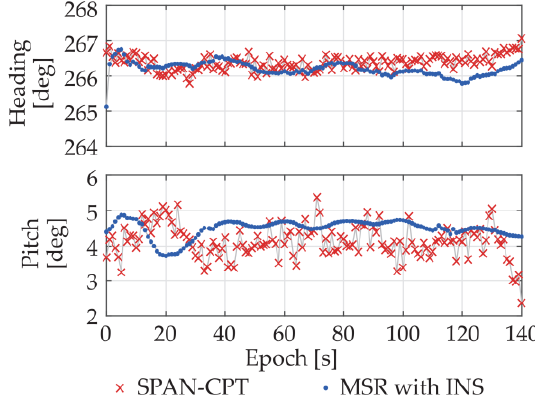
Figure 17. First 140-s static attitude results of MSR-based GNSS/INS integrated system.